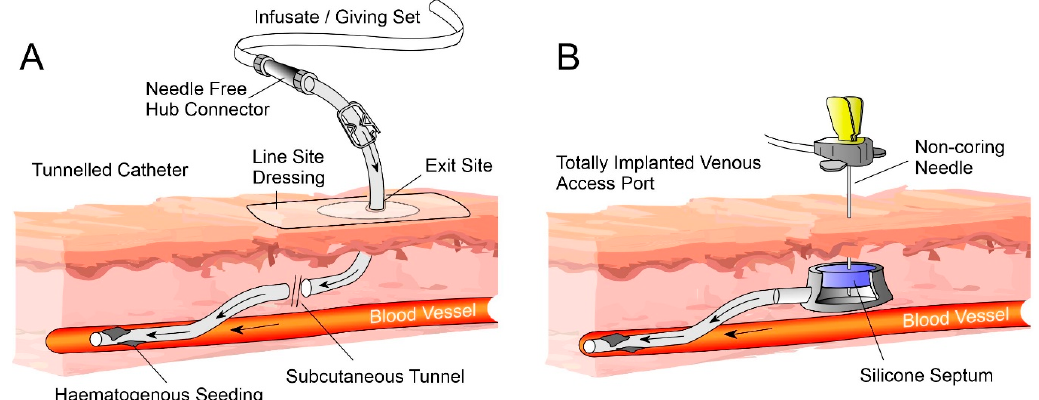
Figure 1. ( A ) Tunnelled central venous catheter and associated components. ( B ) Totally implantable venous access